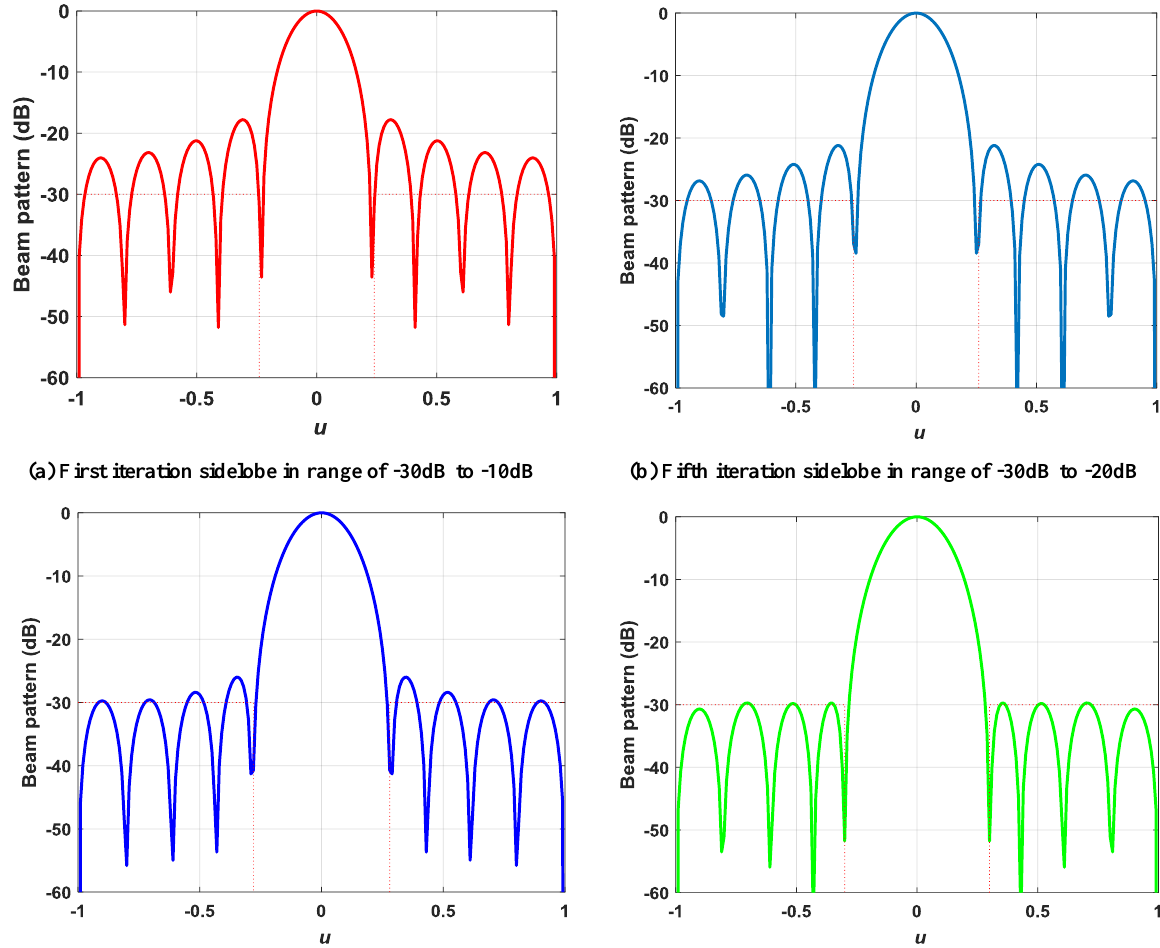
Figure 9. Iteration approaches for SLL -30dB sidelobe